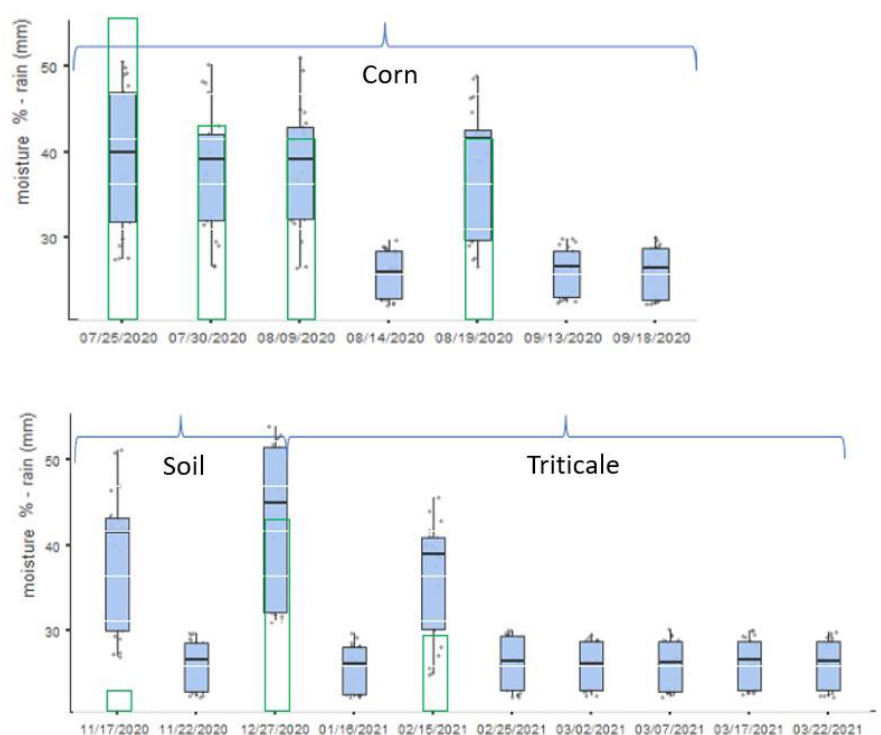
Figure 4. Distribution of soil water content (%) and precipitation (mm, green line box) in the period of observation.